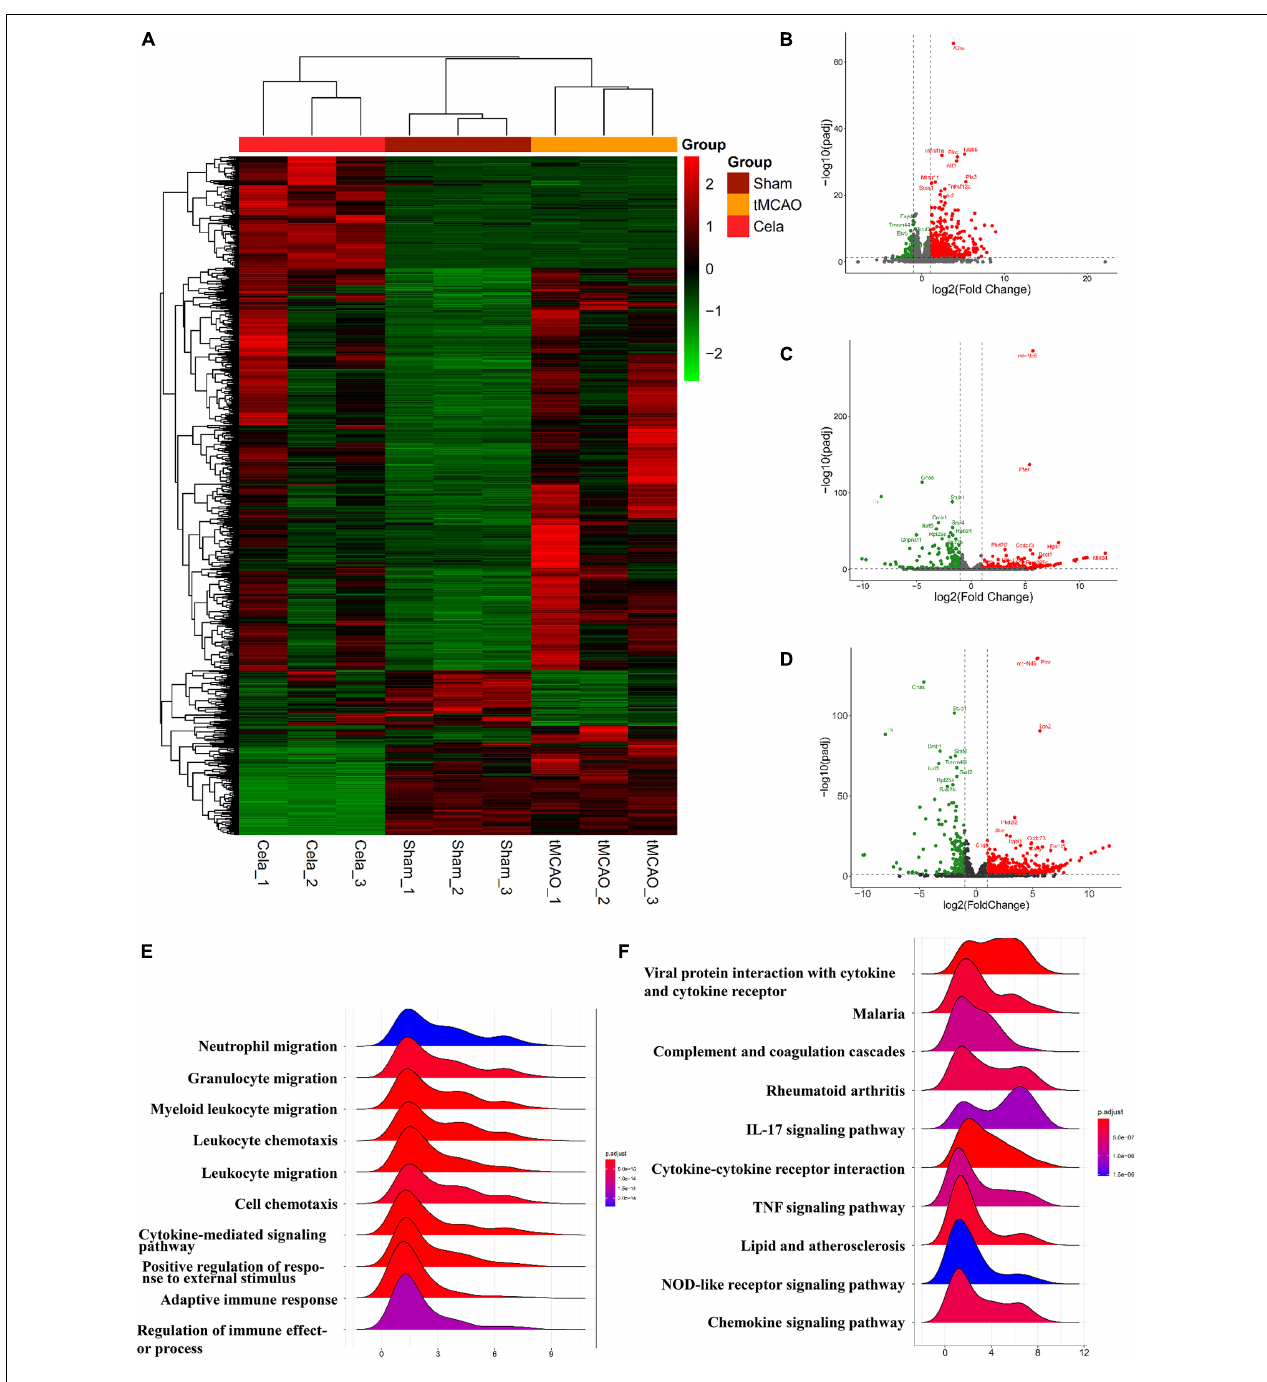
FIGURE 2 | (A) The heatmap of DE lncRNAs and DE mRNAs. (B–D) The volcano plot of the mRNAs between sham and tMCAO group, tMCAO and tMCAO + celastrol group, sham and tMCAO + celastrol group. (E) Top 10 enrichment biological processes of GO analysis of DE mRNAs between the sham and tMCAO group. (F) Top 10 enrichment pathways of KEGG pathway analysis of DE mRNAs between the sham and tMCAO